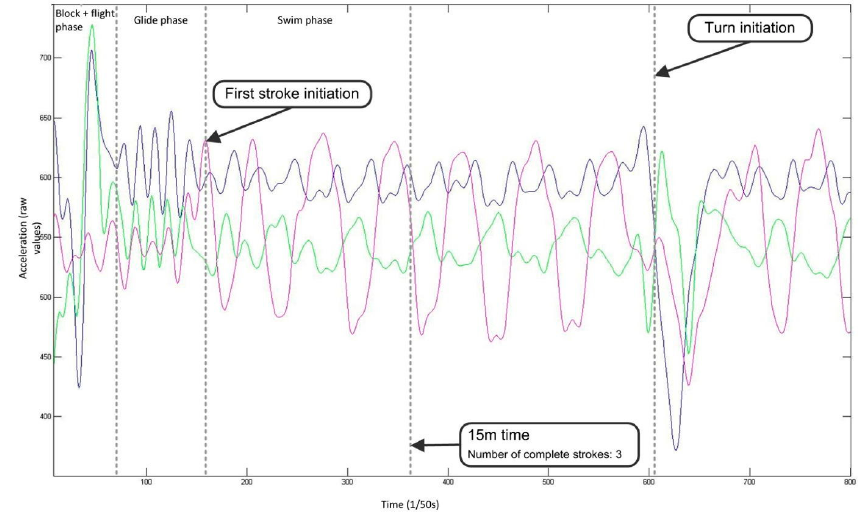
Figure 24. The acceleration signals from a back worn sensor device can be used to identify different phases (block, flight, glide, swim) of starts. Additional video input is necessary to determine the end of the start phase at 15 m. Reproduced with permissions from Le Sage, Bindel, Conway, Justham, Slawson, Webster and West [68].